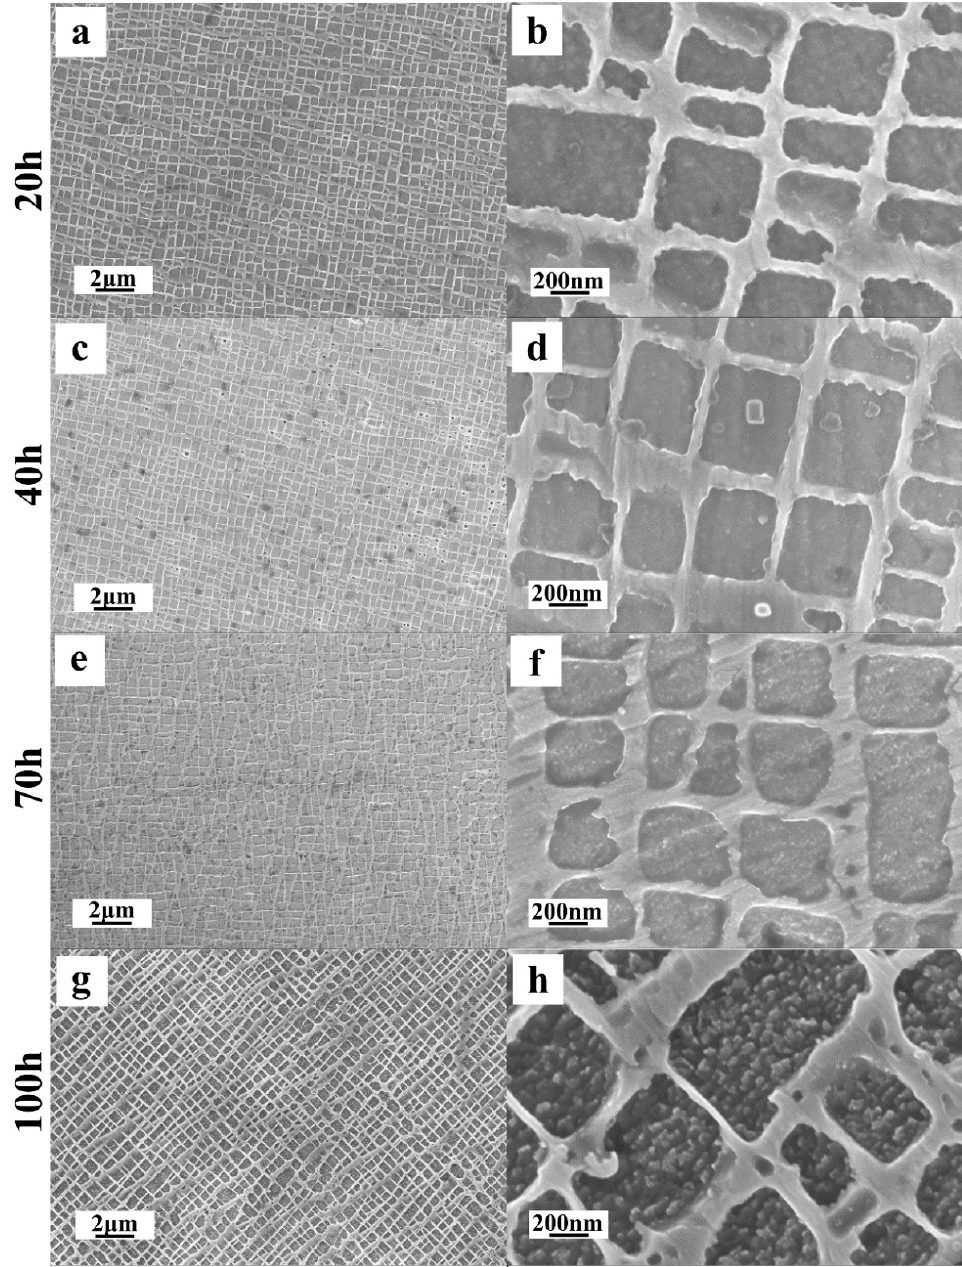
Figure 7. Microstructure of the tested alloy with creep mutation time of ( a , b ) 20 h ( c , d ) 40 h ( e , f ) 70 h ( g , h ) 100 h after second aging heat treatment (870 °C × 32 h (AC)).